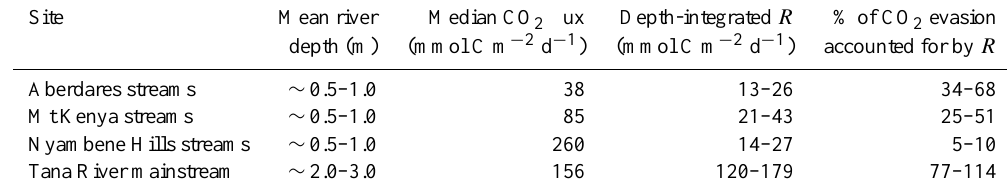
Table 2. Comparison between CO 2 flux evasion and depth-integrated R during the 2009 wet season